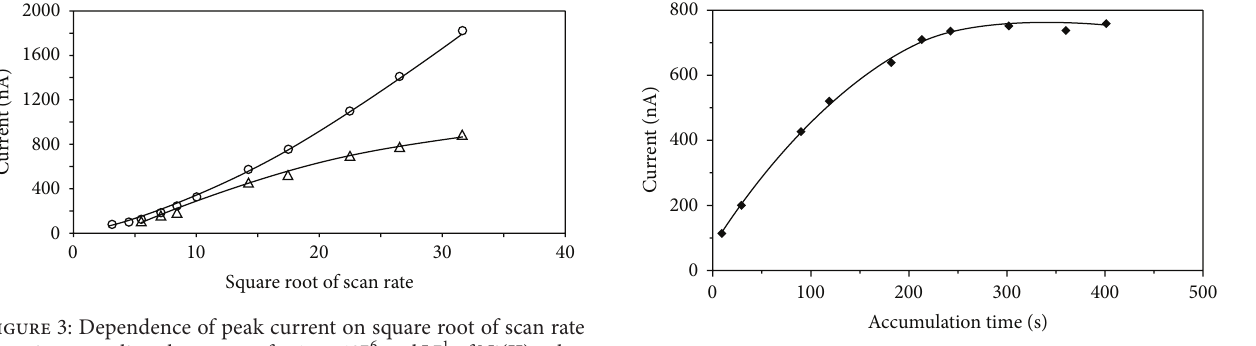
Figure 4: The effect of accumulation time on the current of the square-wave stripping peak for 2.1 × 10 −7 molL −1 Ni(II)-salen complex in phosphate buffer (0.02 molL −1 , pH 7.0). Accumulation time at − 700mV with stirring. Potential step height ( 𝐸 -step): 4 mV. SW- 𝑎 : 30 mV and SW- 𝑓 : 30